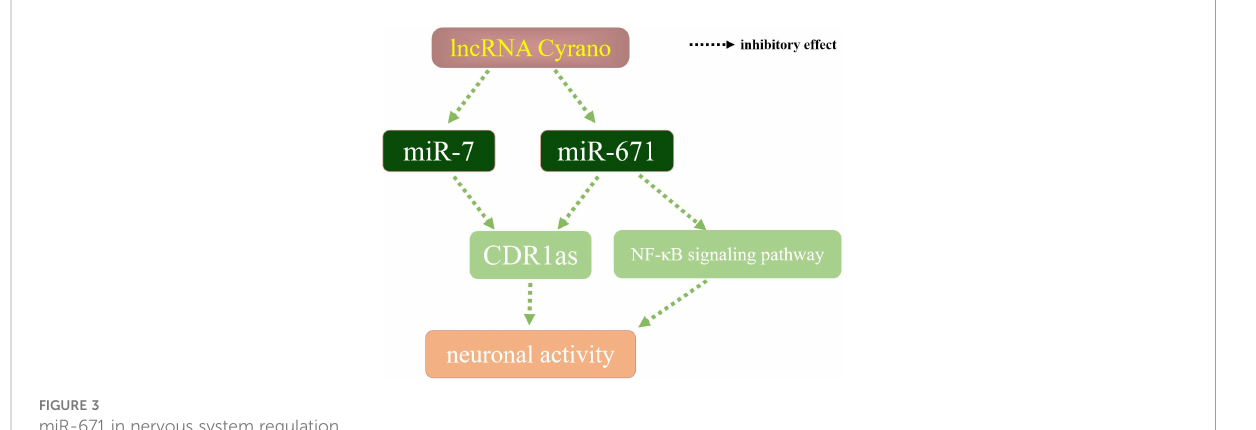
FIGURE 3 miR-671 in nervous system